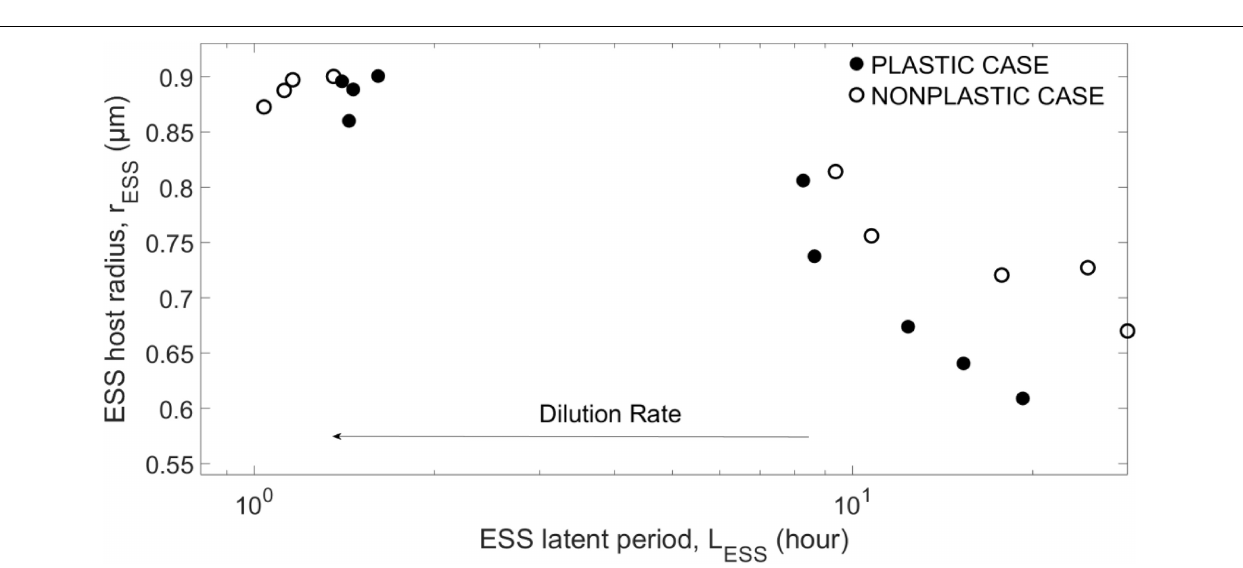
FIGURE 2 | Median across replicates for the host, viral and nutrient concentrations averaged over the last 20 days of each replicate, as a function of the dilution rate. Note that small dilution rate led to wide oscillations [e.g., for w = 4 d − 1 in the plastic case N varies between10 − 8 and 10 − 5 mol l − 1 ].